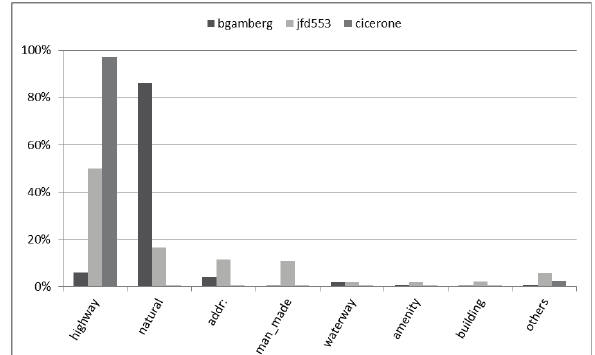
Figure 3 Percentages of features edited by each of the three main contributors.